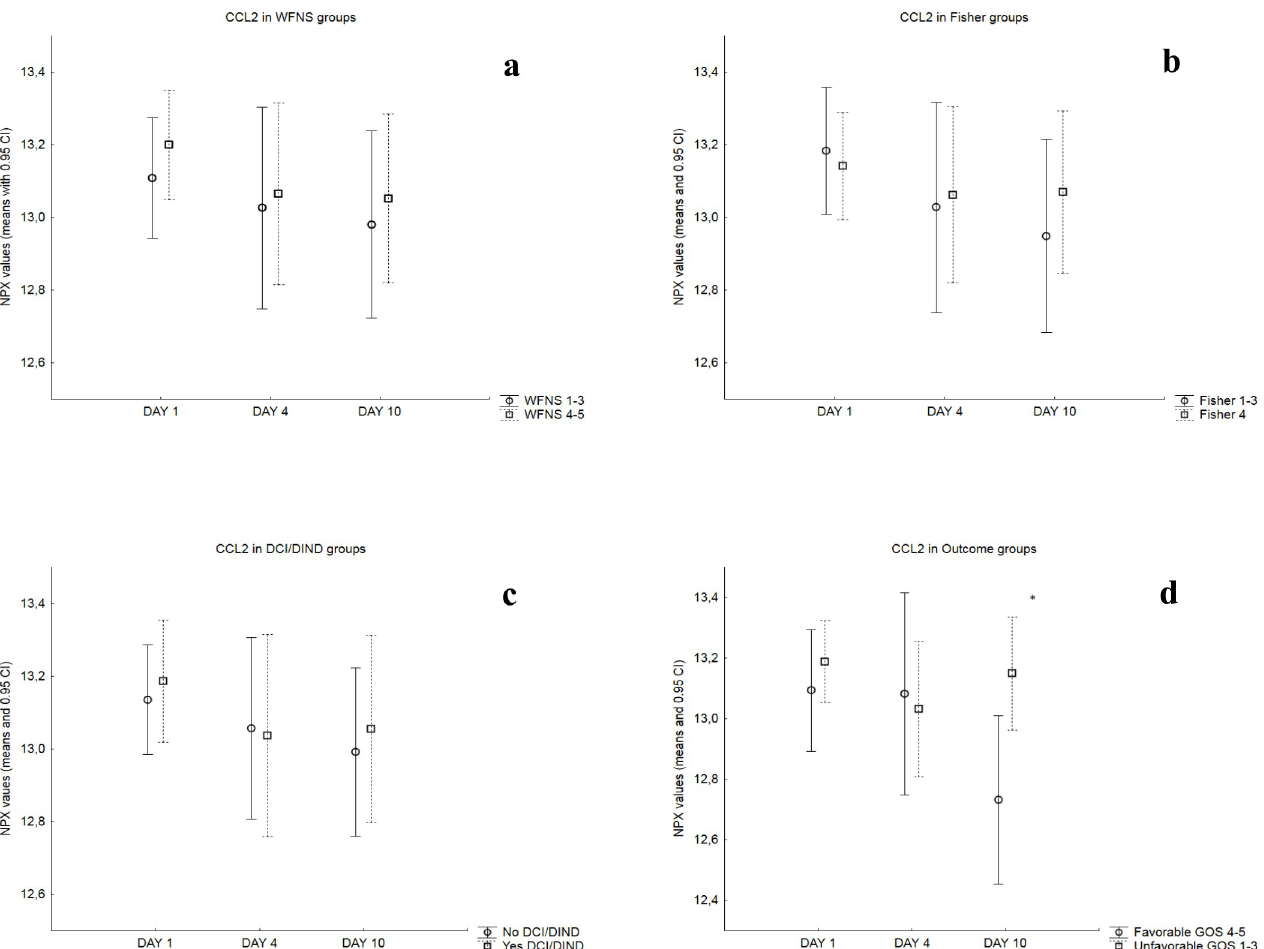
Fig 2. Comparisons of CCL2 NPX values in patient groups: Mean NPX values and 0.95 CI for each day in dichotomized patient groups based on a) WFNS score on admission ( top left ), b) Fisher scale of admission CT ( top right ), c) occurrence of DCI/DIND ( bottom left ) and d) clinical outcome ( bottom right ). The asterisk on the bottom right image marks significantly higher day 10 mean NPX values for patients with unfavorable outcome.